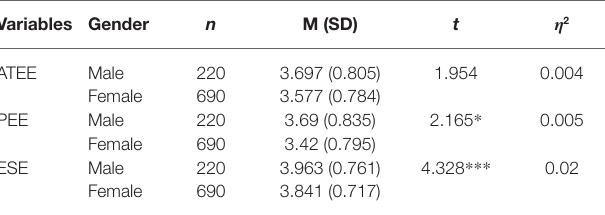
TABLE 5 | Regression Analysis on the Moderating Effect of Attitudes toward Entrepreneurship Education on Entrepreneurial Self-efficacy and Post-pandemic Entrepreneurial